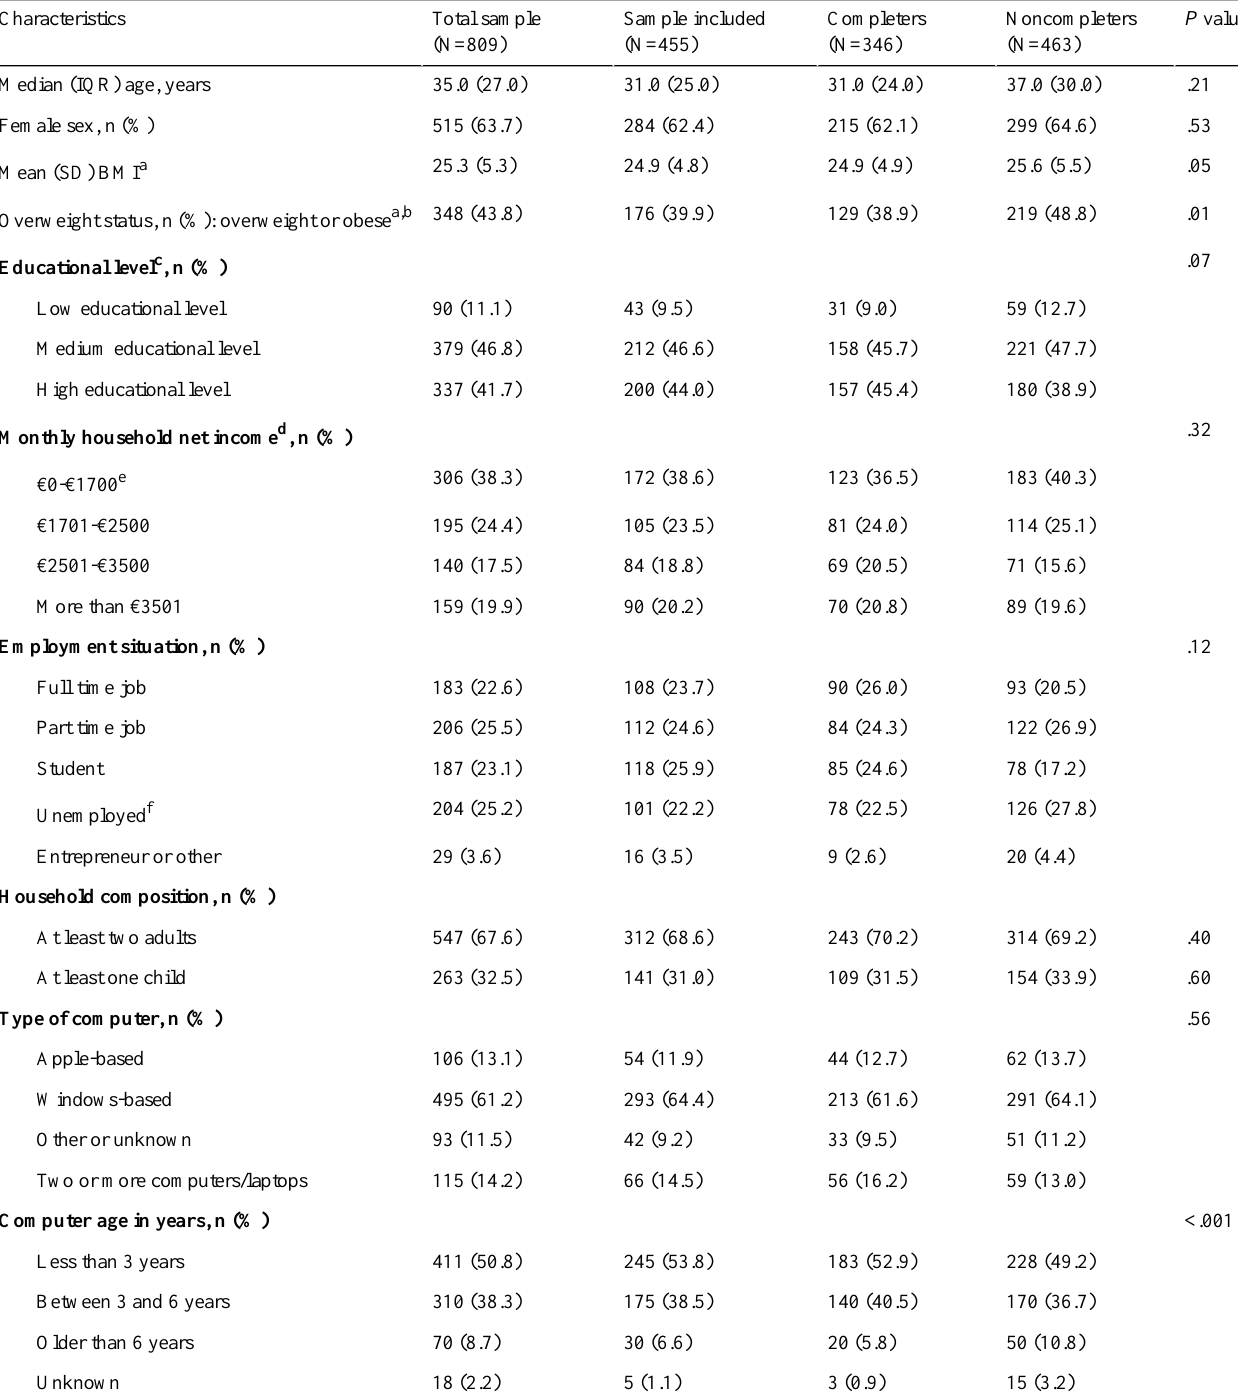
Table 3. Characteristics of the study population who completed and did not complete the